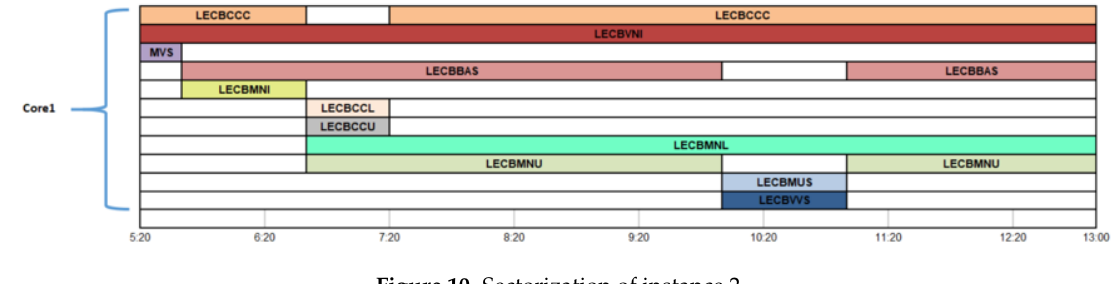
Figure 10. Sectorization of instance 2.